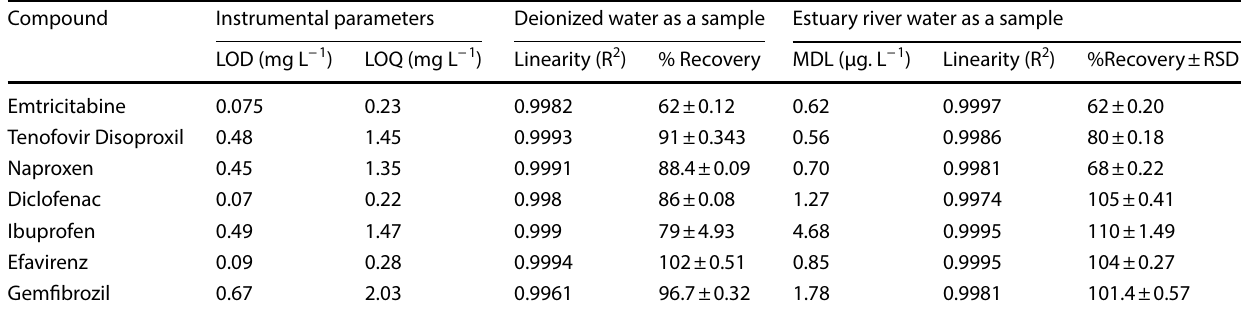
Table 3 Quality assurance parameters